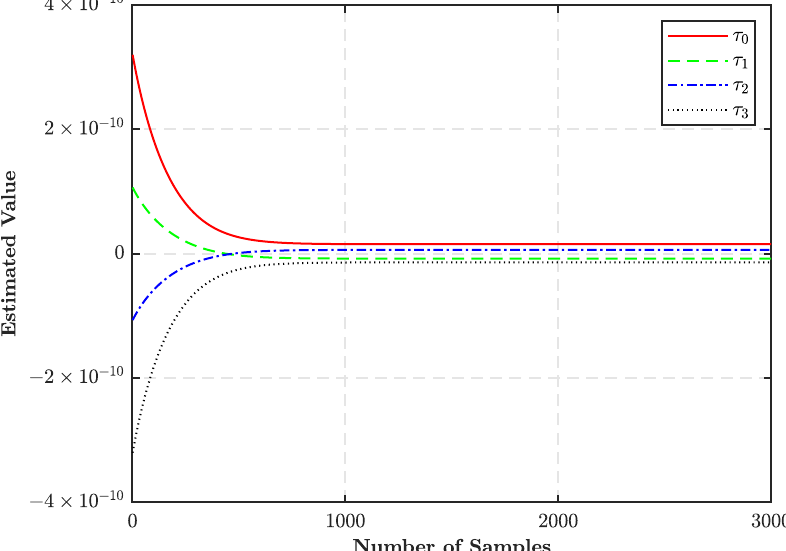
Figure 10. The calculation speed of the proposed estimation algorithm when the MMA sample number N = 128.